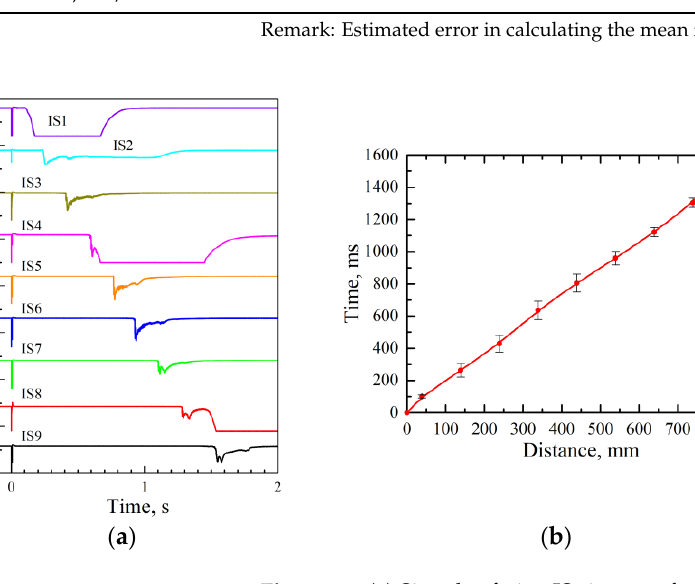
Figure 10. ( a ) Signals of nine ISs in one of seven experiments with fuel-lean 12%vol. hydrogen–air mixture, ( b ) the time–distance diagram of flame propagation, and ( c ) the mean flame velocity along the tube.